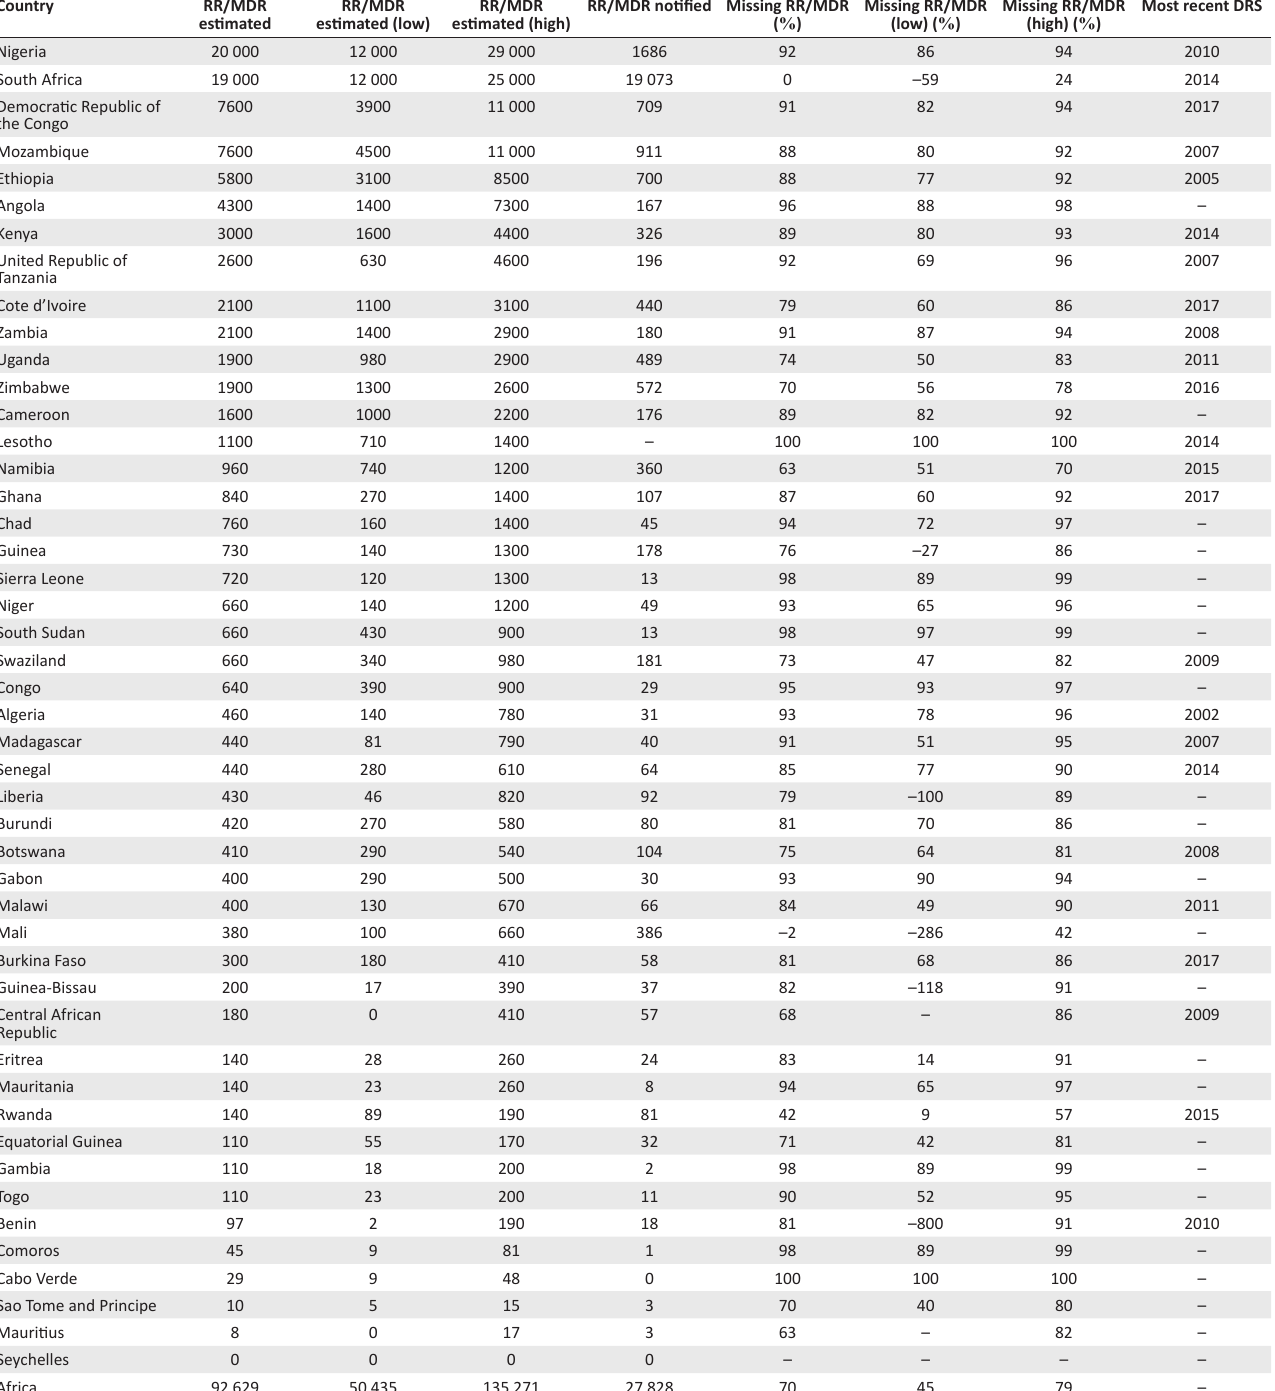
TABLE 2: Comparison of rifampicin-resistant and multi-drug-resistant tuberculosis burden estimated with notified, ordered from highest to lowest estimated burden: 2016.